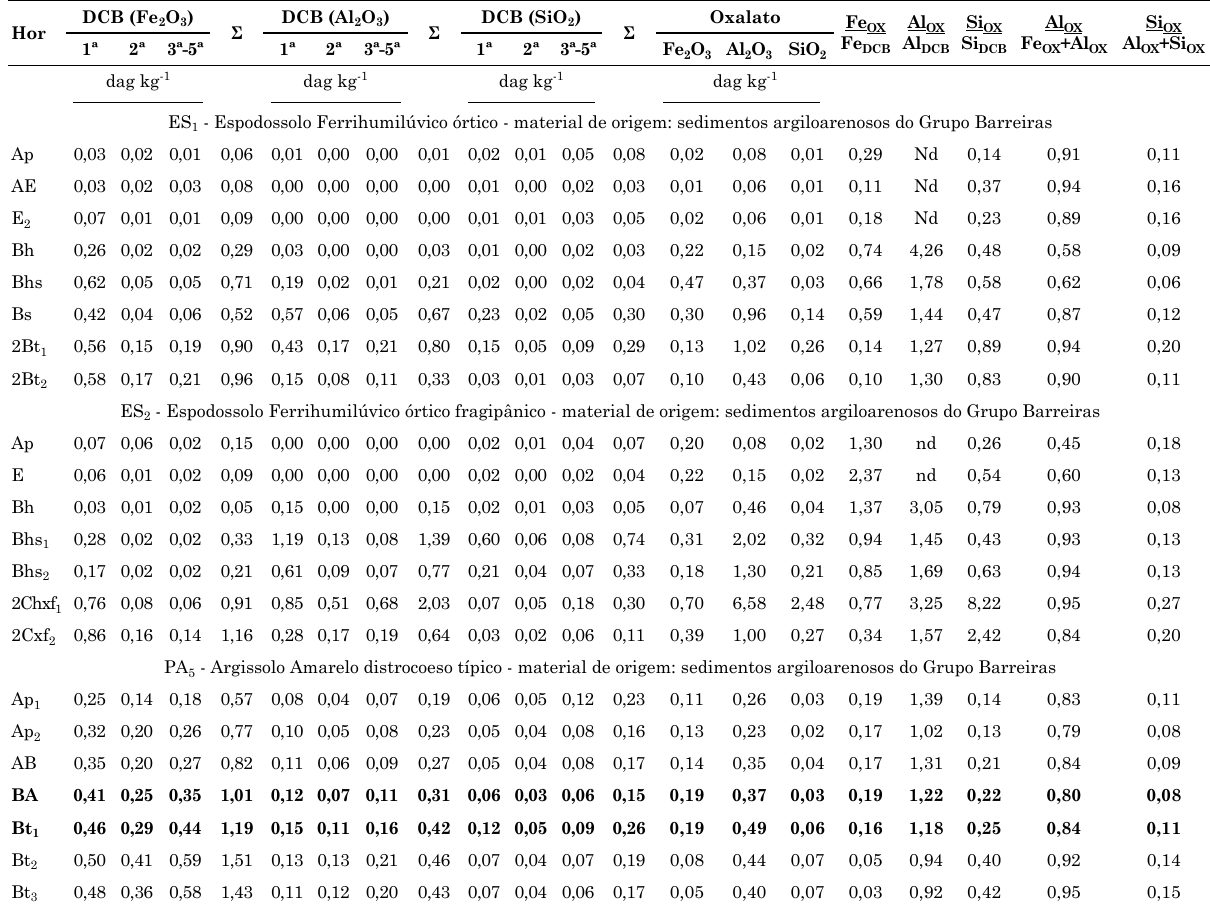
Os horizontes em negrito correspondem aos coesos identificados no